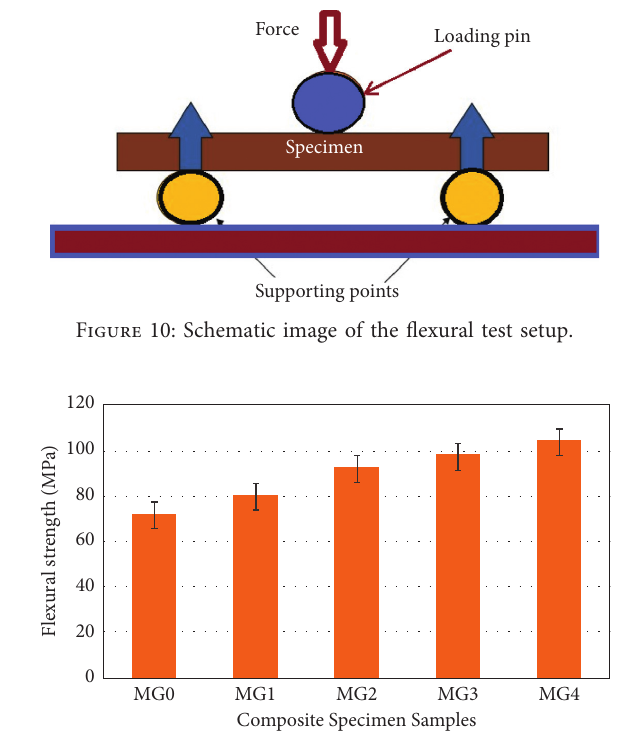
Figure 11: Variation on flexural strength of composite